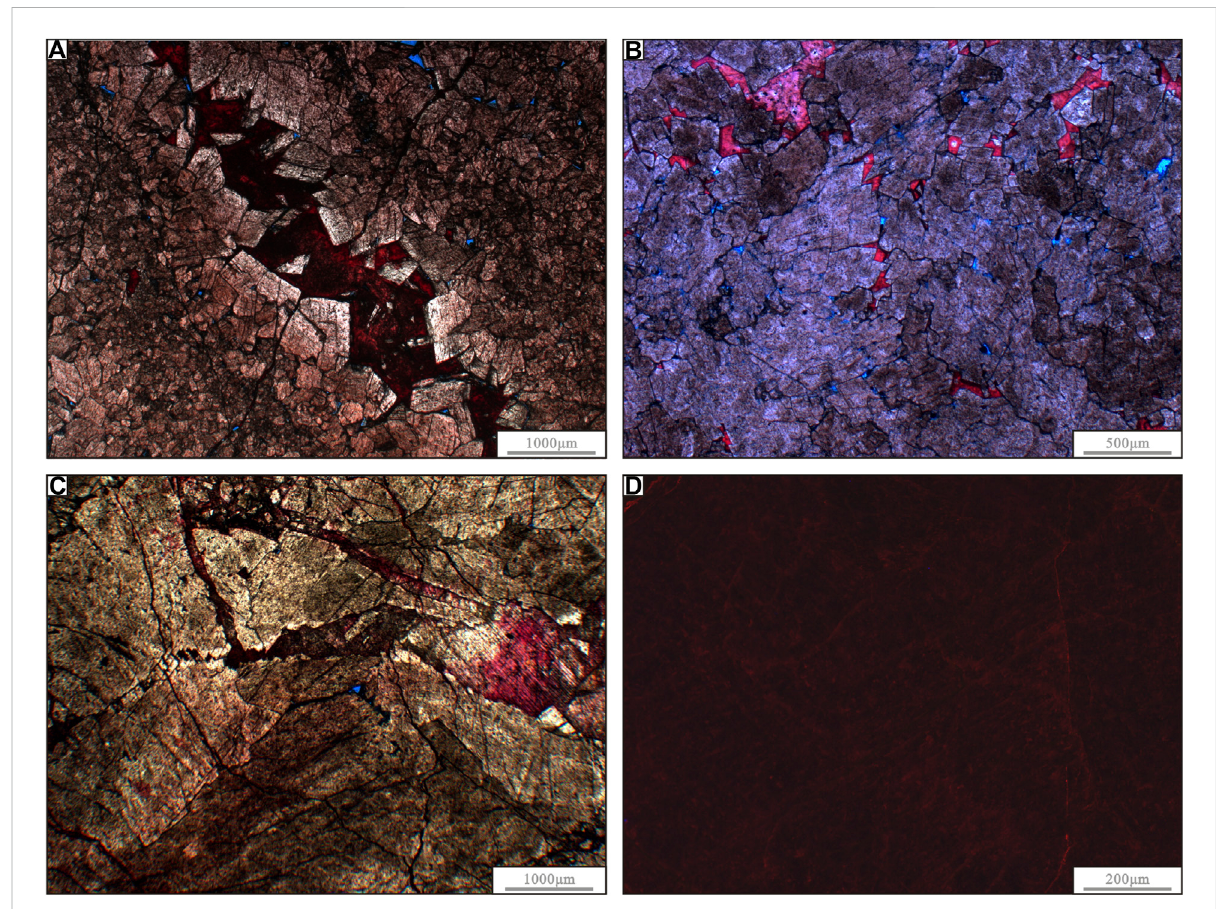
FIGURE 6 Petrological characteristics of void- fi lling dolomite/dolomite cement. (A) . Plane-polarized-light image of a Cd1 sample with fi ne-medium crystalline size showing dolomite cement fi lling along the inner wall of the calcite- fi lled fracture. The sample was obtained from well QZ12 in the BuquFormationatadepthof62.75 m. (B) .Plane-polarized-lightimageofaCd2sampleshowing fi lledsaddledolomiteinRd3,Thefracturesarewell developed and fi lled with calcite. The sample was obtained from well QZ12 in the Buqu Formation at a depth of 73.38 m. (C) . Plane-polarized- lightimageofaCd2sampleshowingsaddledolomitewithcalcite- fi lledfractures.ThesamplewasobtainedfromwellQZ11intheBuquFormationat a depth of 580.90 m. (D) . Cathodoluminescence image of the Cd2 sample in (C) . These crystals show no visible